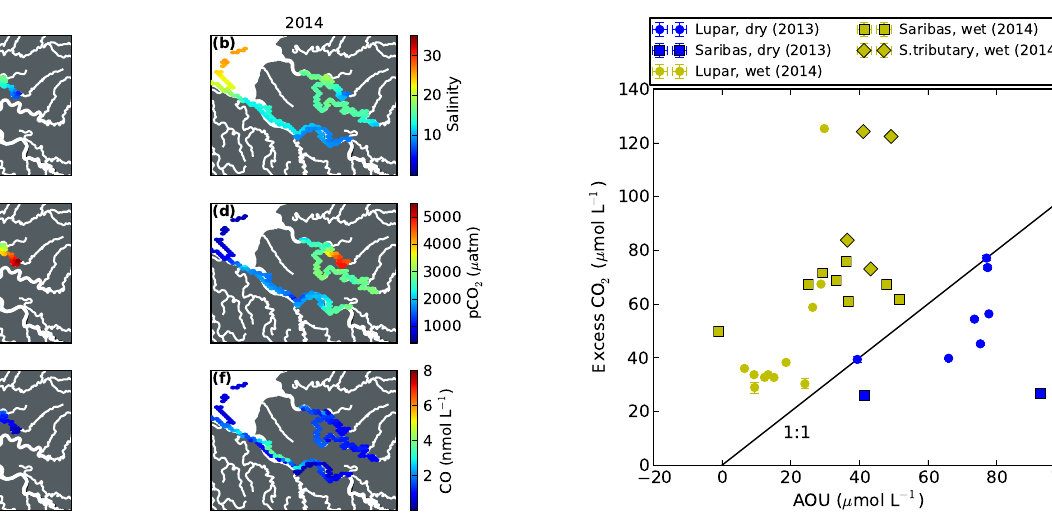
Figure 5. Salinity ( a , b ), CO 2 partial pressures ( c , d ) and CO con- centrations ( e , f ) measured during the two cruises in 2013 (left col- umn) and 2014 (right column).